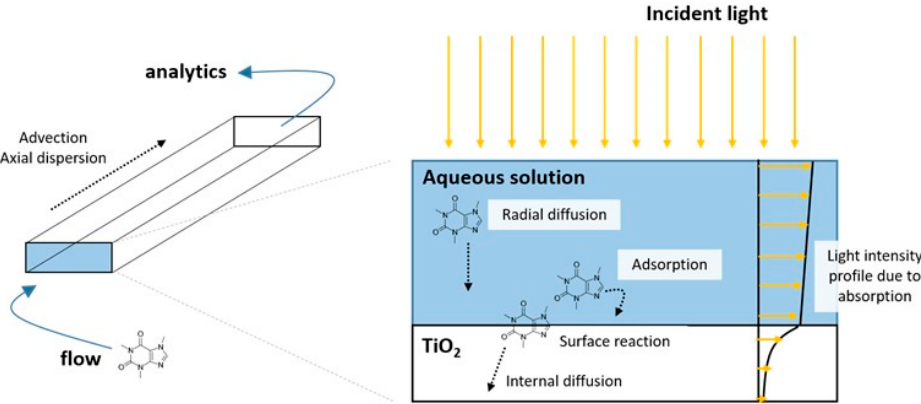
Figure 1. Main mechanisms controlling pollutant degradation in immobilized catalyst microreac- tors.